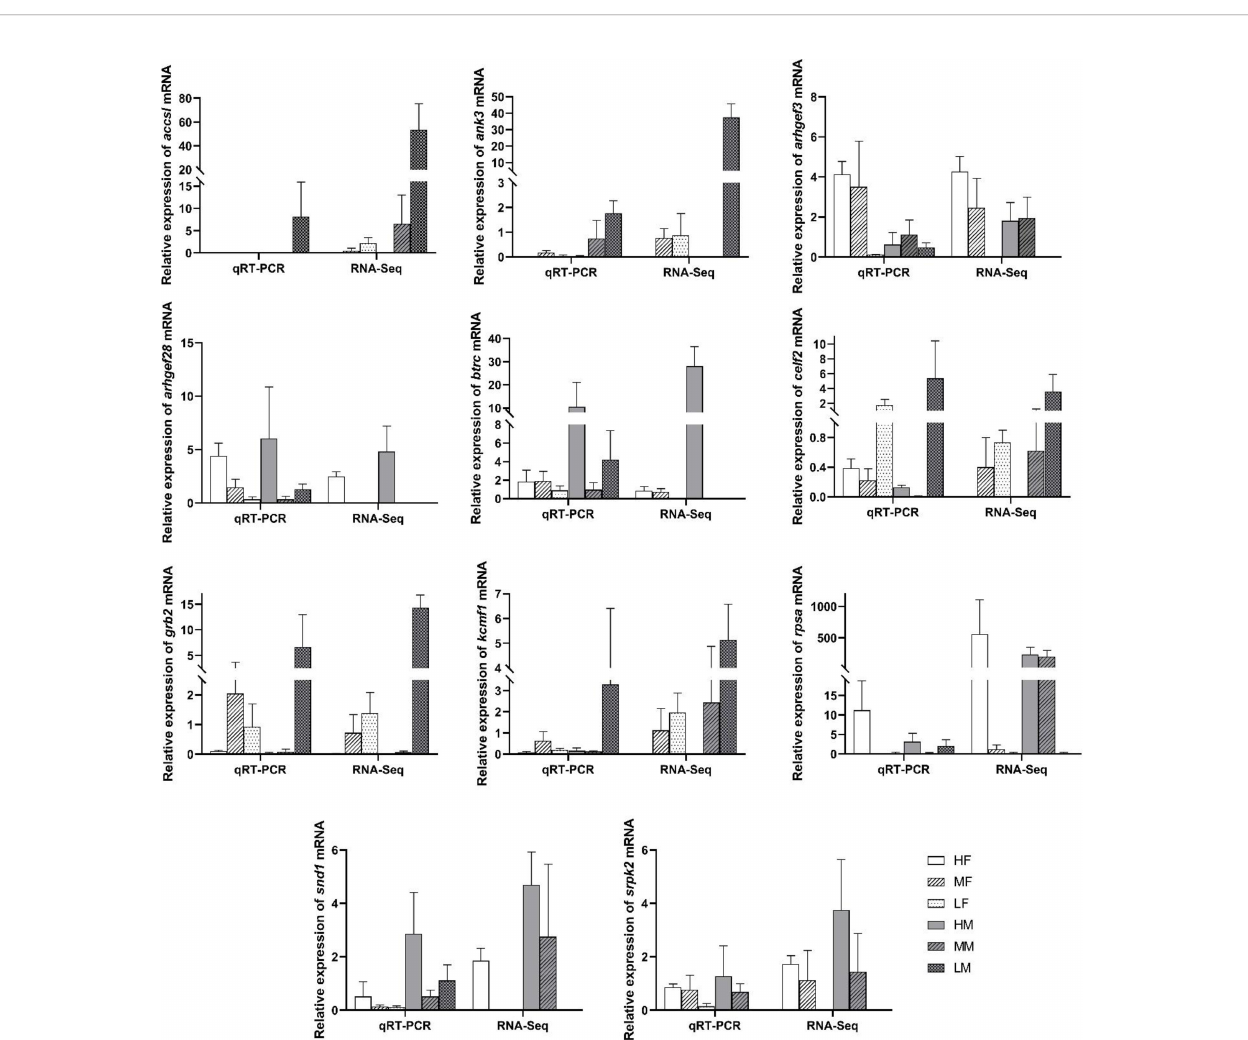
FIGURE 4 | Validation differentially expressed genes (DEGs) in the different sexes and different PUFA abundance groups by qRT-PCR. The relative expression of each gene were normalized to 18 S rRNA gene. Bars represent the mean ± SEM (n=3). Sample name explanation: “ HF ” - high concentration of PUFA in ovaries of female sea urchins; “ HM ” - high concentration of PUFA in testes of male sea urchins; “ MF ” - medium concentration of PUFA in ovaries; “ MM ” - medium concentration of PUFA in testes; “ LF ” - low concentration of PUFA in ovaries; “ LM ” - low concentration of PUFA in